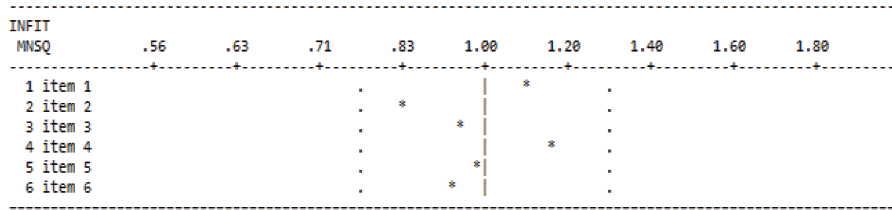
Figure 2. Results of the analysis of mathematical communication from infit mean square